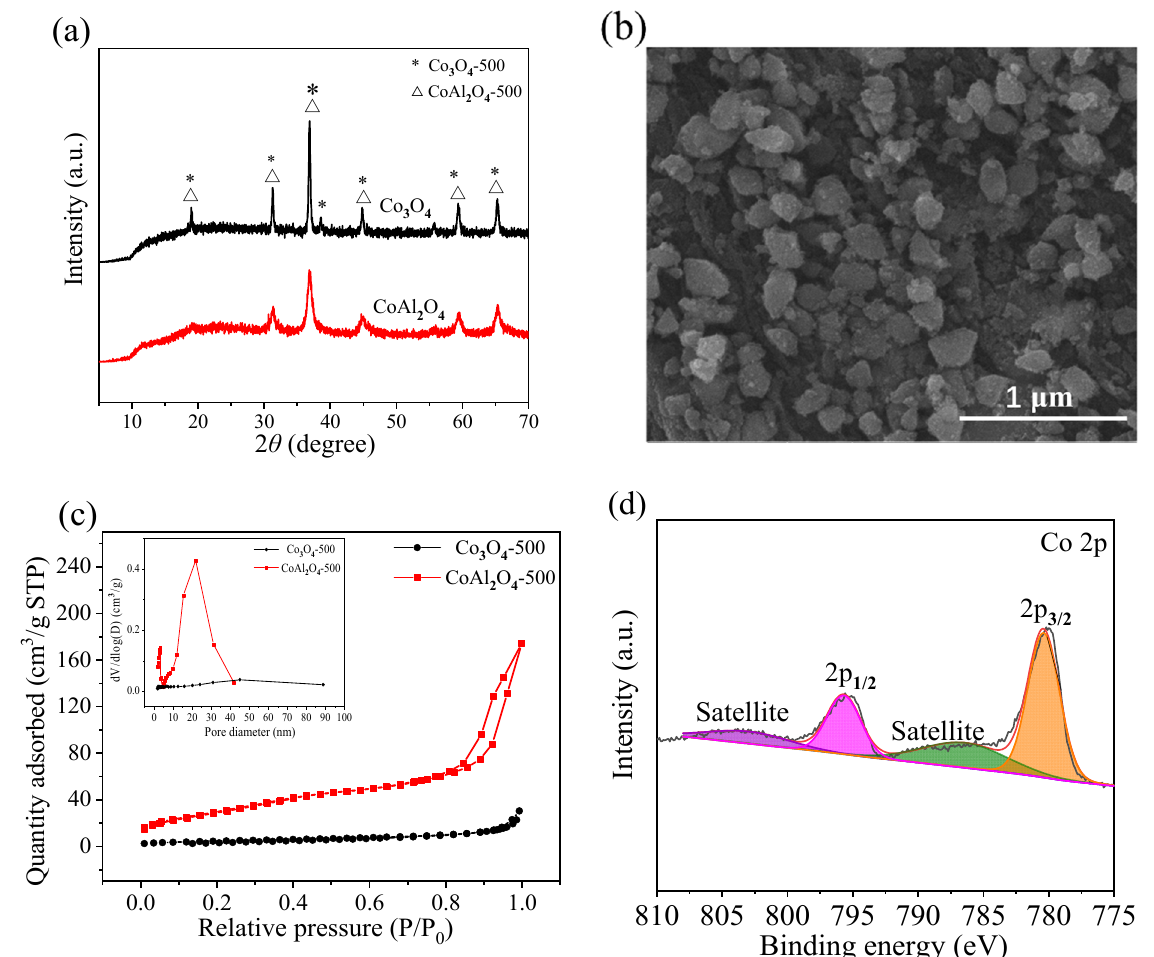
Figure 1. ( a ) XRD patterns of CoAl 2 O 4 − 500 and Co 3 O 4 − 500, ( b ) SEM image of CoAl 2 O 4 − 500, ( c ) N 2 absorption − desorption isotherms and pore size distributions (inset) of CoAl 2 O 4 − 500 and Co 3 O 4 − 500, and ( d ) Co 2p XPS spectrum of CoAl 2 O 4 − 500.